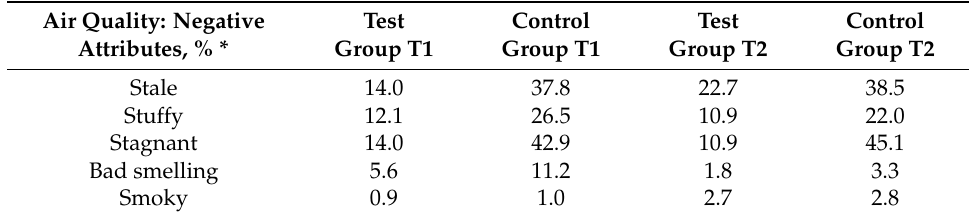
Table 4. Negative perception of indoor air quality in both groups at T1 (three months after moving in) and T2 (one year later).